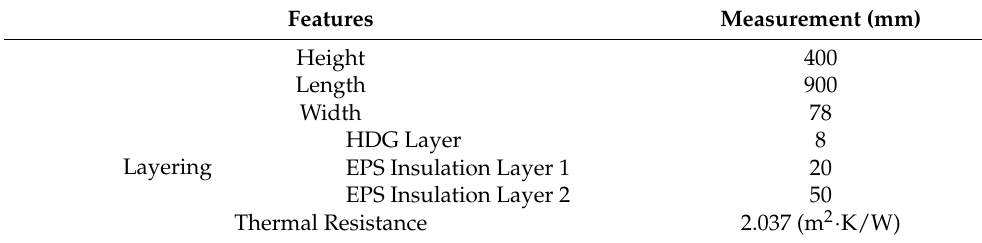
Table 1. ETICS (External Thermal Insulation Composite System)-like panel description. HDG: High-density geopolymer; EPS: Expanded